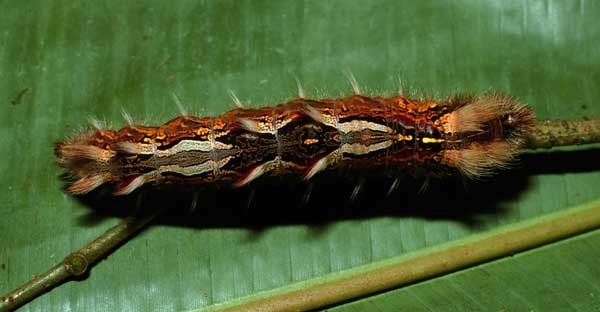
Morpho
helenor voucher n. 89-SRNP-735a, feeding on Fabaceae. Image voucher n. DHJ11620.jpg